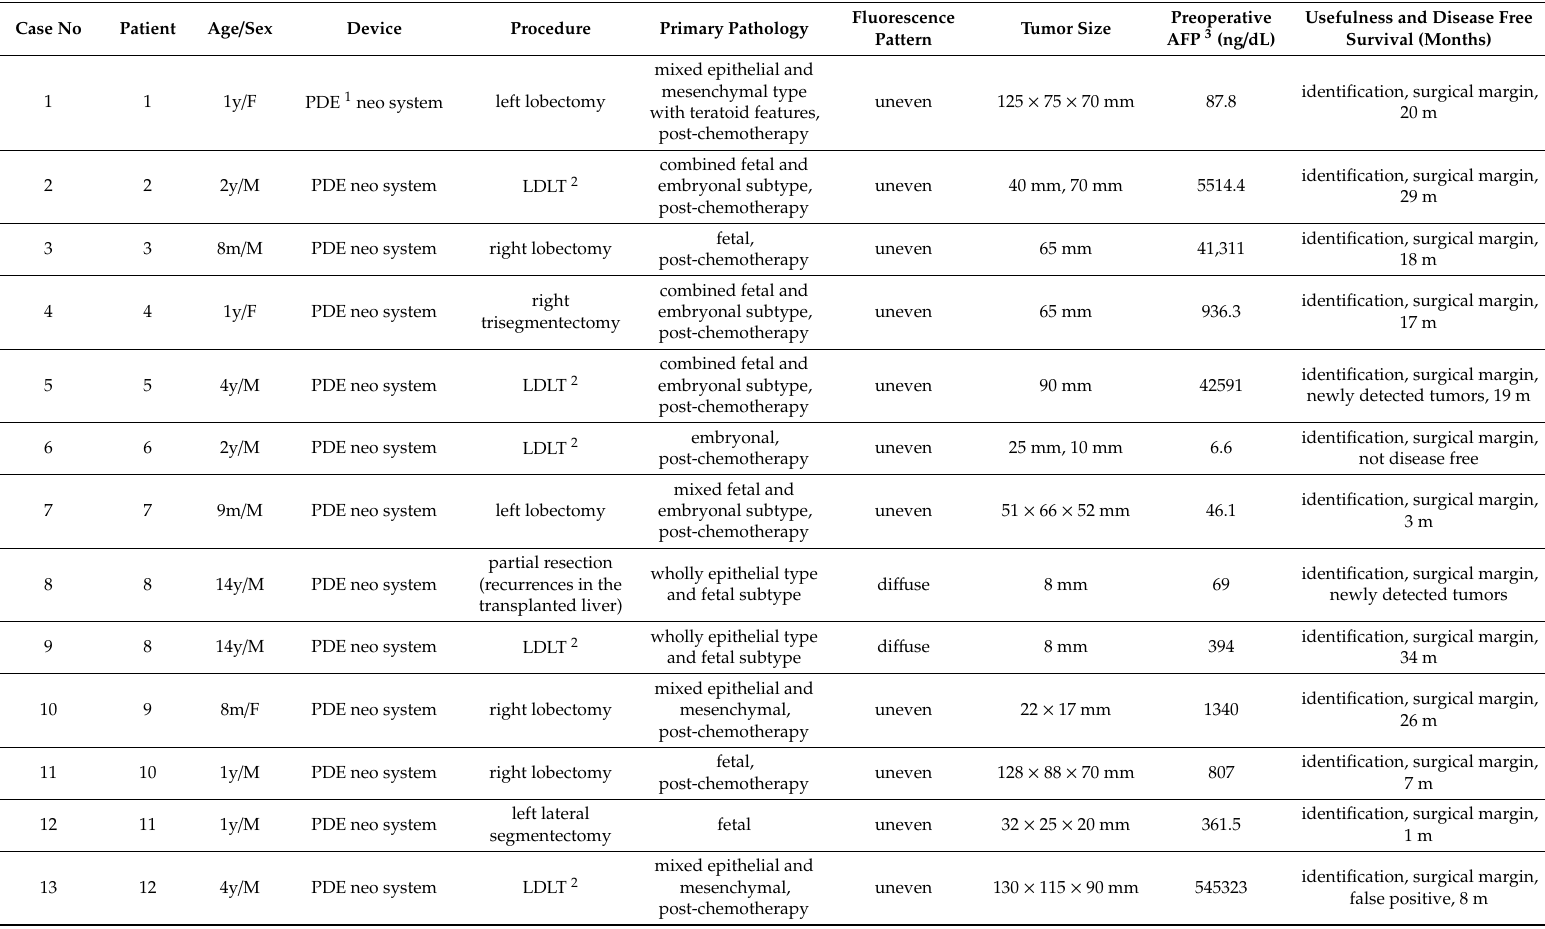
Table 1. Thirteen liver resections for 11